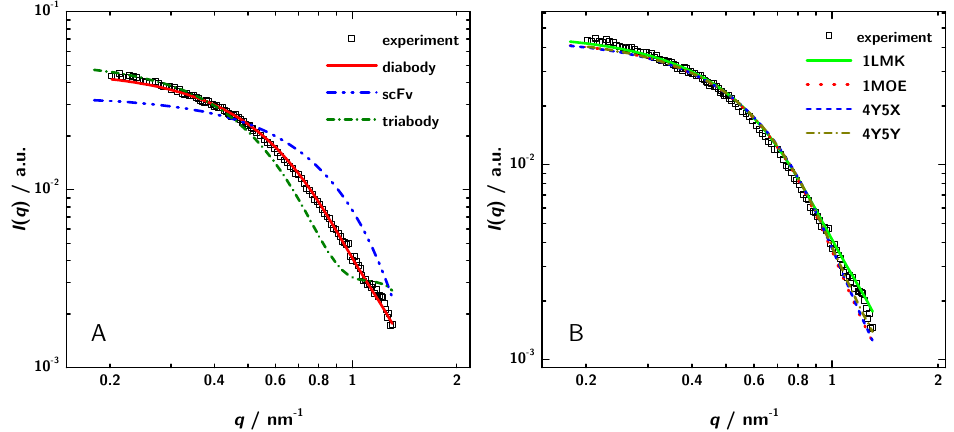
1 Figure 6. ( A ) Comparison of simulated scattering patterns of a monomeric scFv, a diabody and a triabody computed with CRYSOL to experimental data. ( B ) Comparison of theoretically calculated scattering paterns of several different diabodies with the experimental data. The scattering patterns of the different diabodies were obtained using the PDB entries and CRYSOL. The shown experimental data were obtained for the sample with a concentration of 5mg · mL − 1